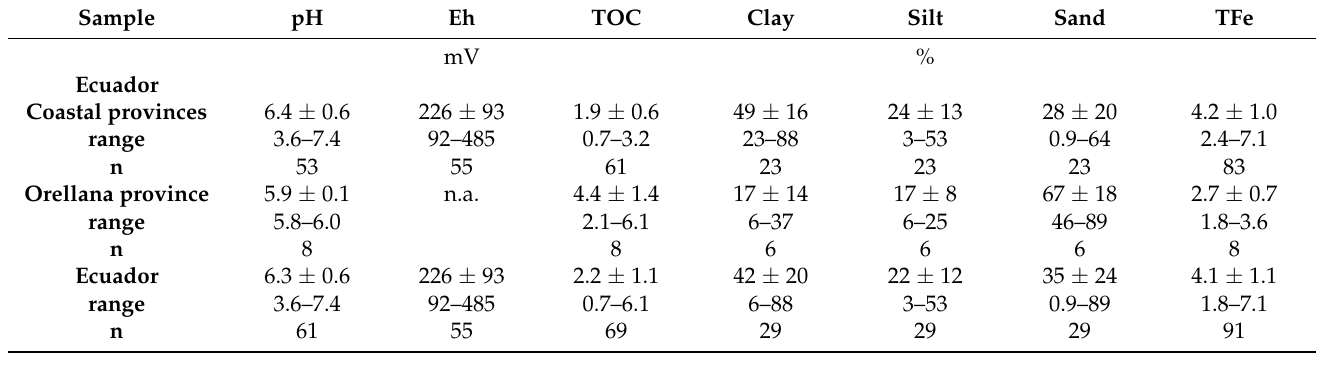
Table 1. Soil properties: pH and Eh, and composition: total organic carbon [TOC], texture, total Fe [TFe]. (Minimum and maximum values are shown between parentheses).